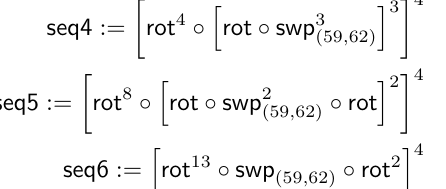
and rot in 2 full rounds, i.e 2 × 64 cycles. (11 , 15) ◦ τ M ◦ τ M ◦ τ M . And for τ N operations, 0 1 2 3